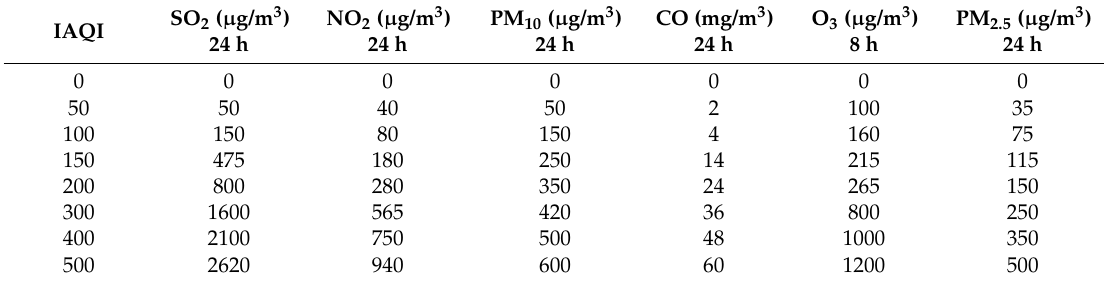
Table 1. Breakpoints for the individual air quality index (IAQI) according to the standard of the Ministry of Environmental Protection